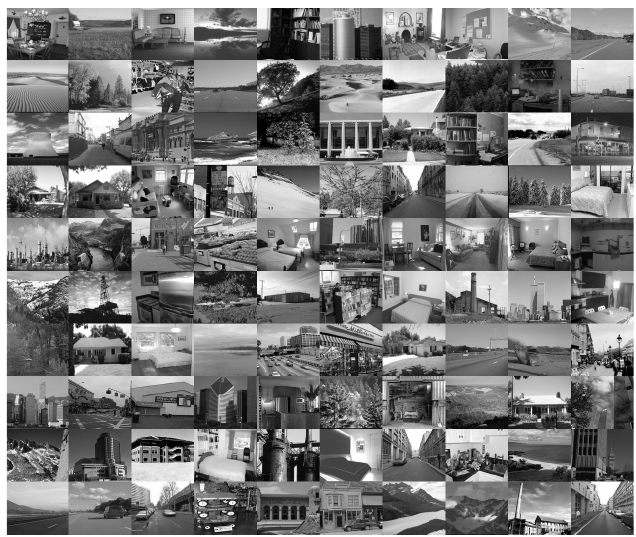
Fig. 4. A set of 100 images in the dataset. The initial size of images is various.